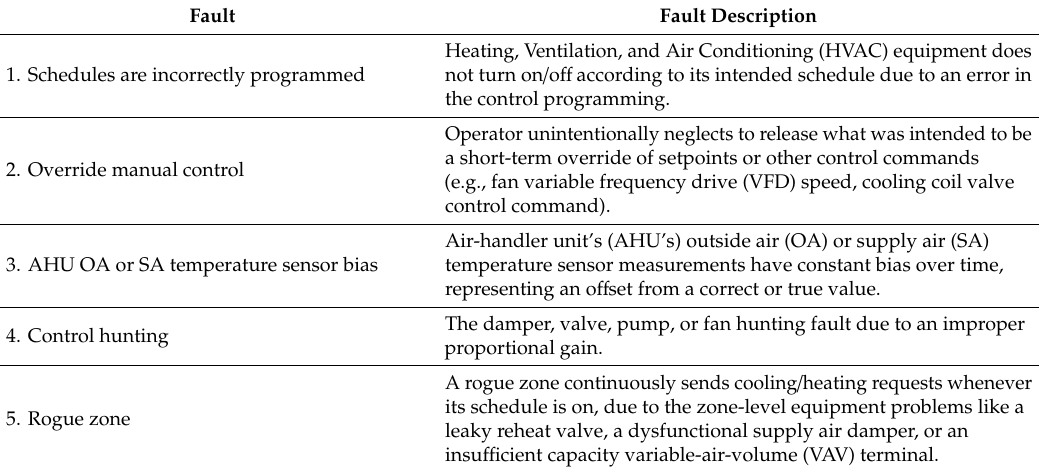
Table 1. Summary of the auto-correctable faults of focus in this